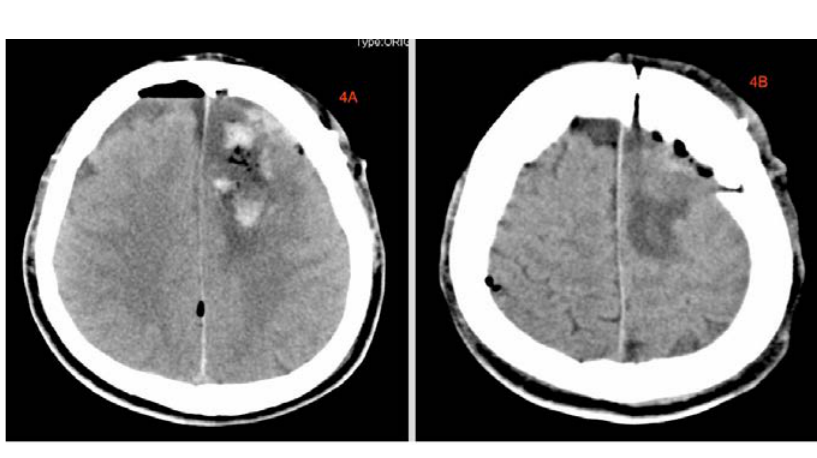
Figure 4. Postoperative CT-Scan images showing to total evacuation of the